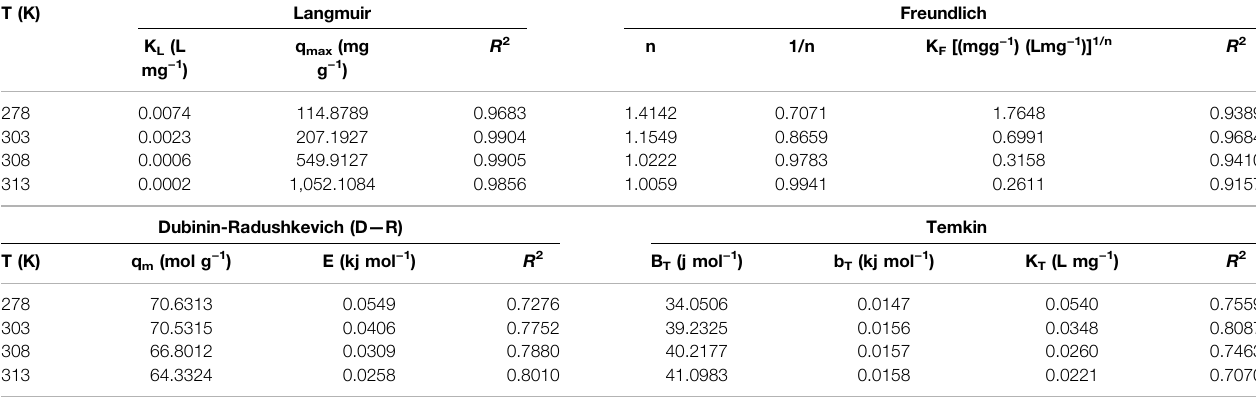
TABLE 2 | Langmuir, Freundlich, Dubinin-Radushkevich (D – R) and Temkin Redlich-Peterson, Sips and Toth adsorption isotherm values and correlation coef fi cients. T